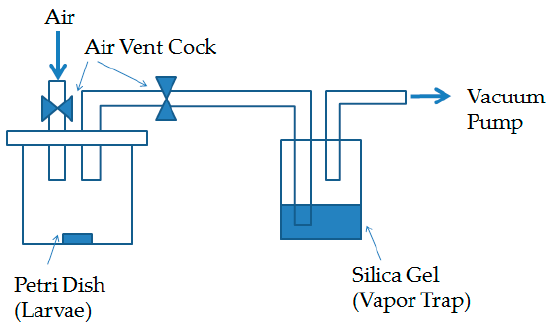
Figure 1. Experimental set-up for the high vacuum treatment (1.1 kPa).